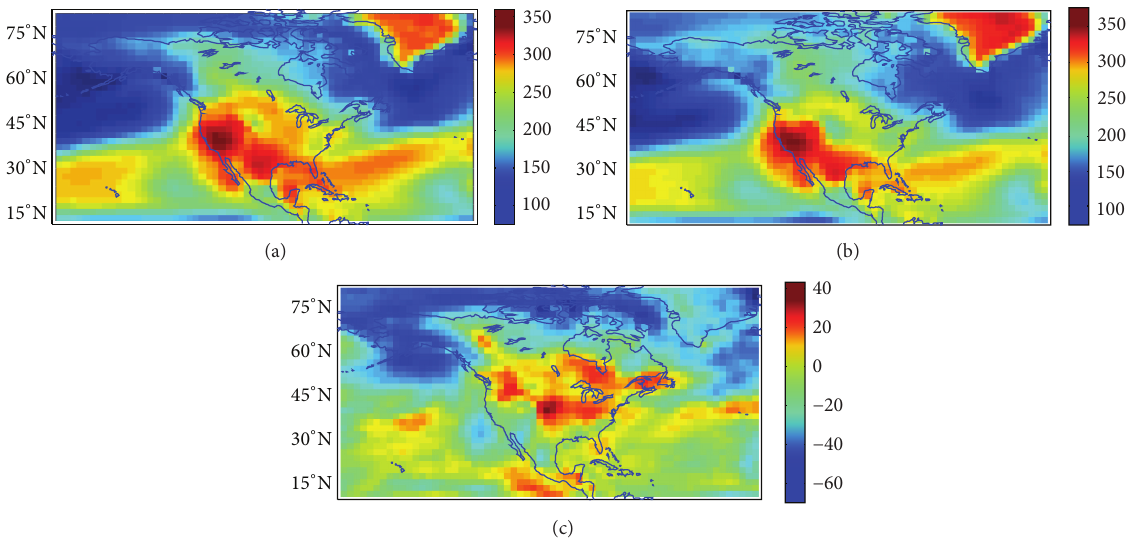
Figure 1: (a) The July climatology of downward shortwave radiation at the surface over North America from the 21st century run with GFDL CM2.0, based on 2080–2100 average. (b) The same as (a) but from the 20th century run, based on 1980–2000 average. (c) The trend, defined as (a) minus (b). The color scales with units in W/m 2 are shown on the right.